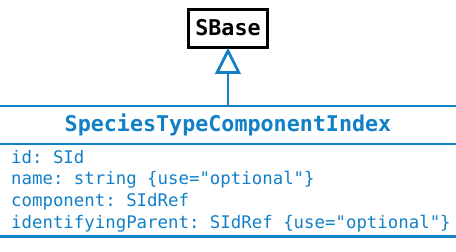
Figure 6: The definition of the SpeciesTypeComponentIndex